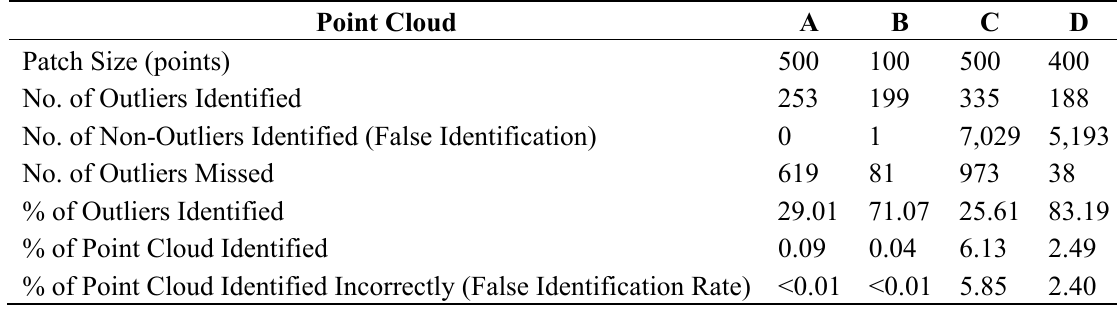
Table 5. Results from trials conducted using Quadratic Polynomial Surface Fitting (CSF) on point clouds A, B, C and D using test statistic 2 in Equation